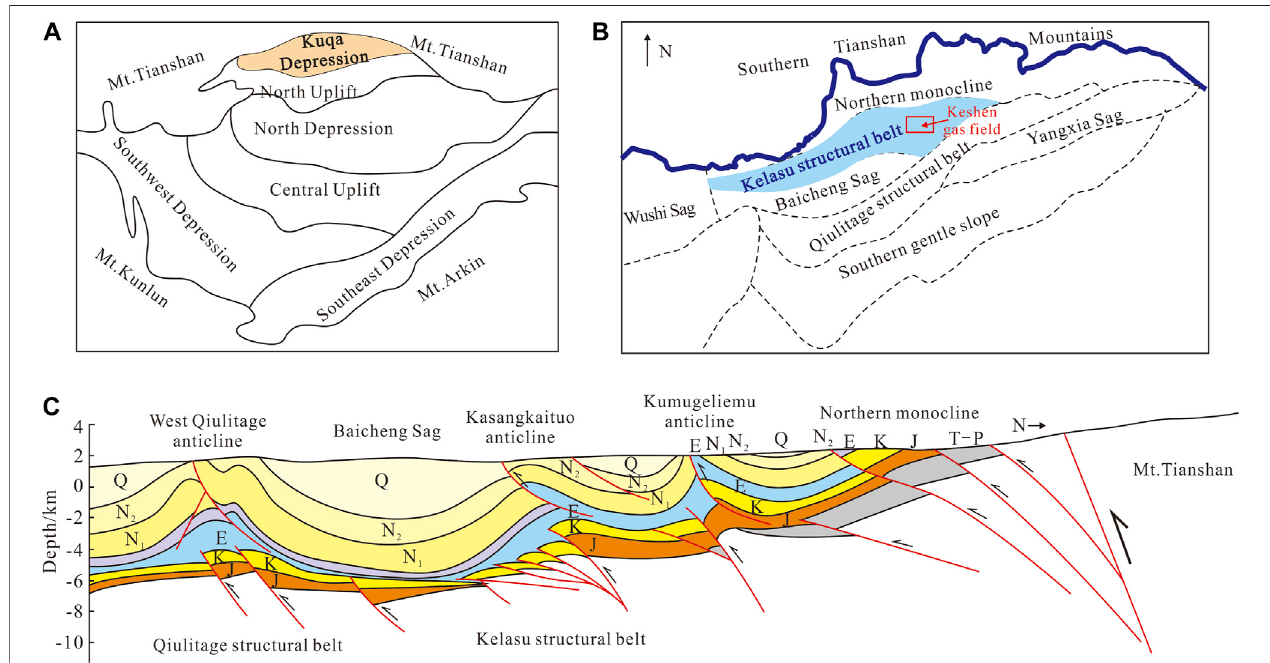
FIGURE 1 | Division of structural units and geological pro fi le of the Kuqa Depression. (A) Kuqa depression is located in the north of Tarim Basin; (B) Kuqa depression is divided into seven secondary structural units. Keshen gas fi eld is located in the east of Kelasu structural belt; (C) Thrust imbricate structures are widely developed in Kelasu structural